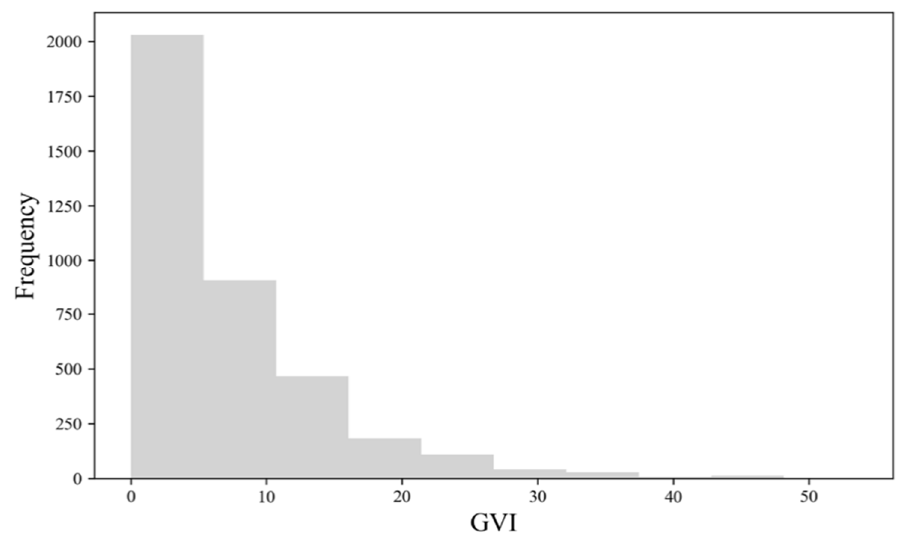
Figure 6. GVI Figure 6. GVI histogram.